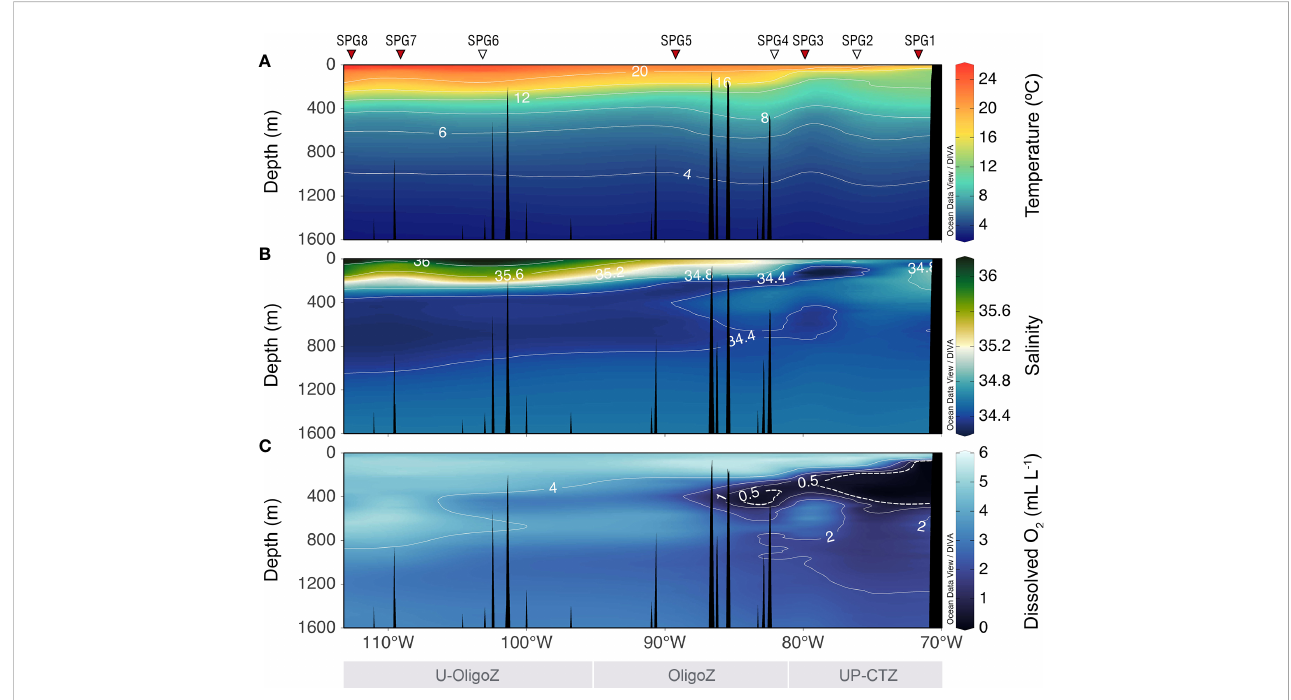
FIGURE 2 Vertical distribution of (A) potential temperature, (B) salinity and (C) dissolved oxygen concentration along the transect surveyed during the EPIC cruise. Dashed line in panel C indicates the oxygen minimum zone typical in the coastal region. Triangles in the top represent the sampling sites, including oceanographic stations (white) and stations for CSIA-AA analyses (red). The upwelling-coastal transition (UP-CTZ), oligotrophic (OligoZ) and ultra- oligotrophic (U-OligoZ) zones are delimited at the bottom.